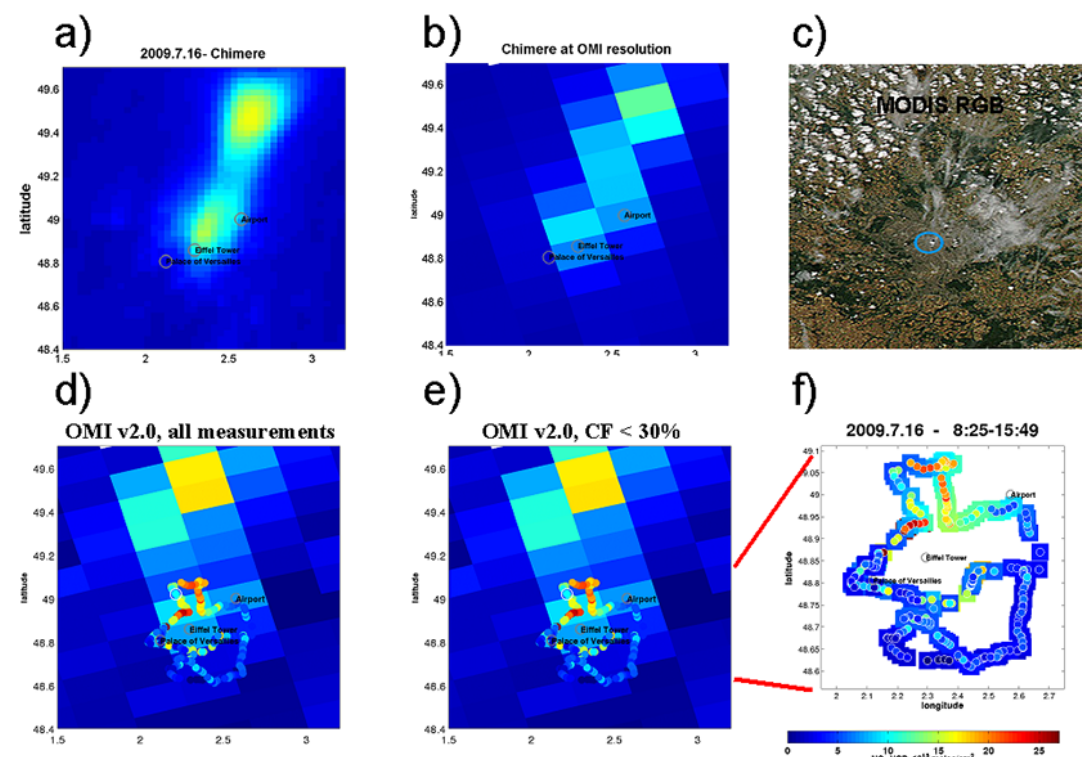
Figure 3. Comparison of the tropospheric NO2 VCDs across the Paris metropolitan area derived from model simulations, satellite ob- servations and car-MAX-DOAS observations on 16 July 2009. (a) CHIMERE model results at the time of the OMI overpass (12:54) at original resolution; (b) CHIMERE results averaged for the individual OMI ground pixels; (c) MODIS RGB image; (d) OMI v2.0 data to- gether with car-MAX-DOAS results; (e) same as (d) but for cloud fraction below 30%; (f) car-MAX-DOAS results (small circles) together with CHIMERE model results extracted for the same time and location of the car-MAX-DOAS data (large squares). The car-MAX-DOAS measurements were performed between 8:25 and 15:49; the measurements around the large circle were performed between 10:07 and